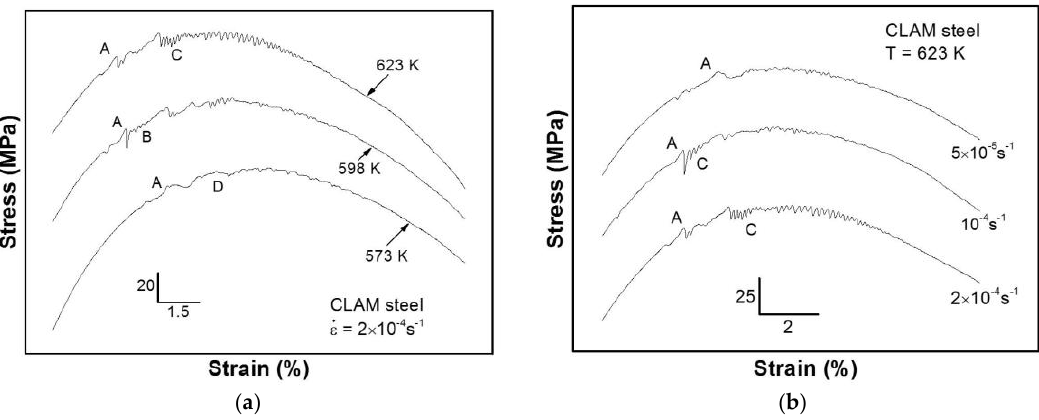
Figure 2. Parts of engineering stress-strain curves in China low activation martensitic (CLAM) steel at ( a ) various temperatures and ( b ) different strain rates, showing diverse types of serrations.